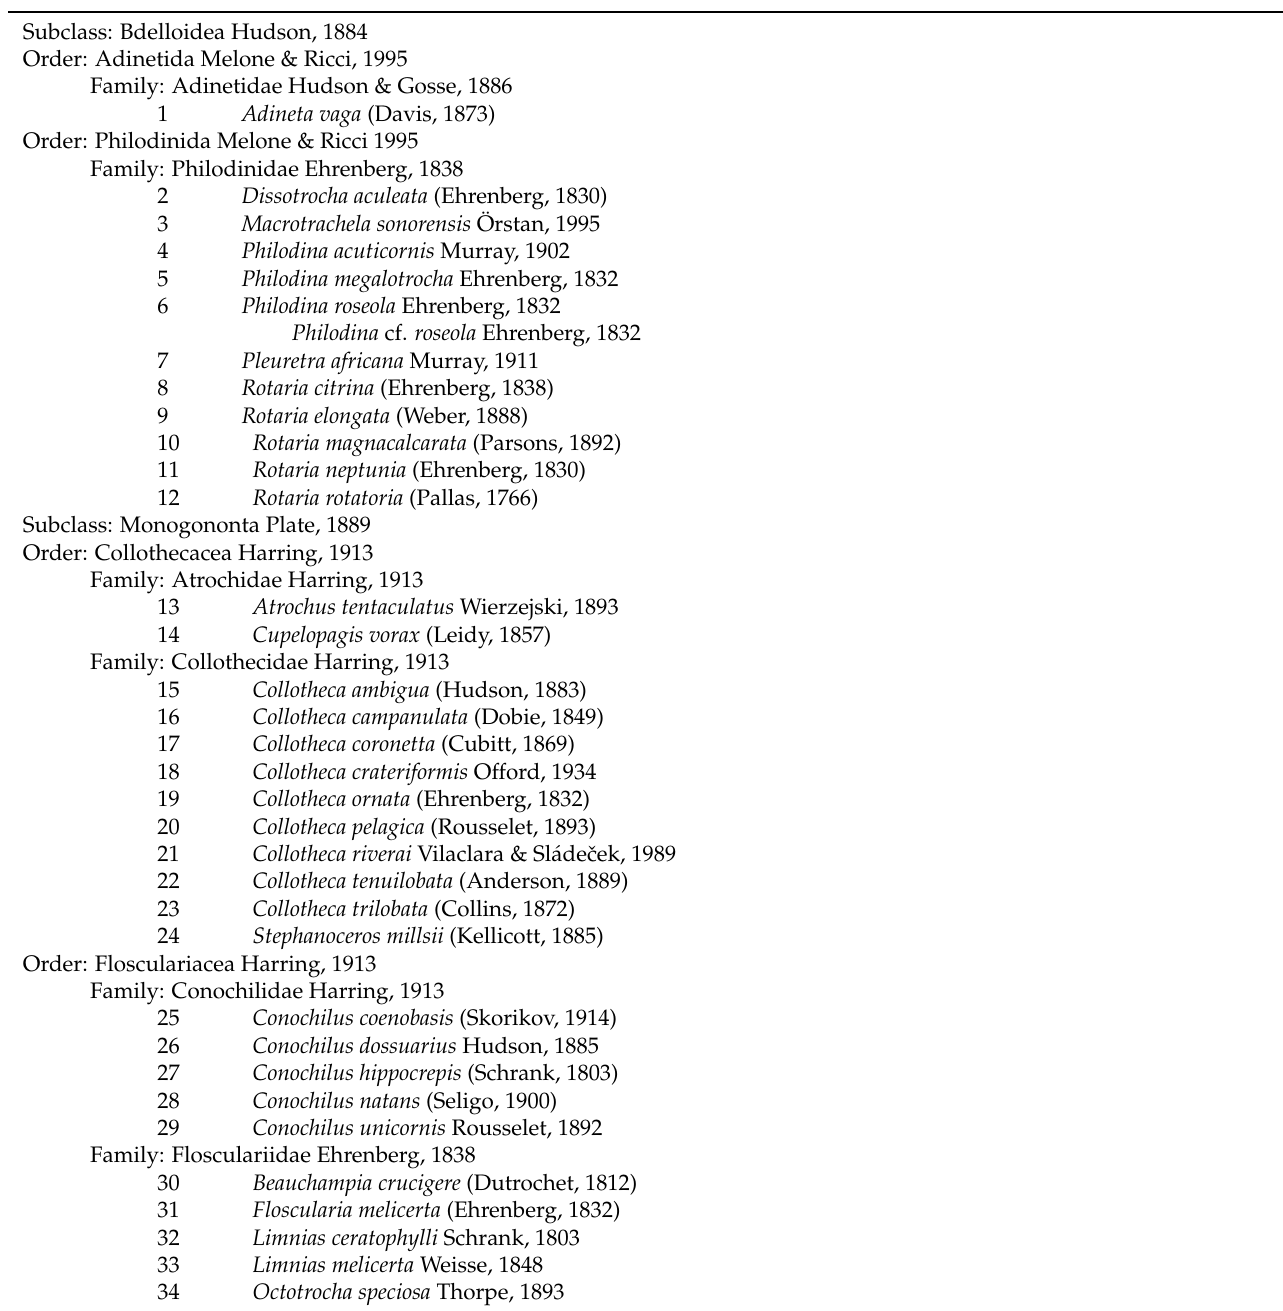
Table 1. Checklist of rotifer species recorded from